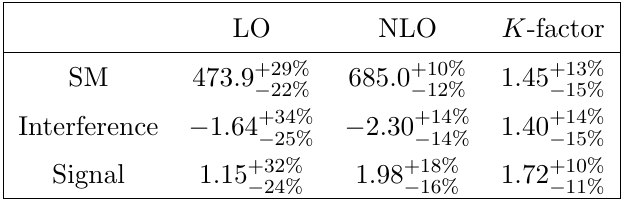
Table 5 . Cross sections for benchmark C1 in pb. Uncertainties are from renormalisation and factorisation scale